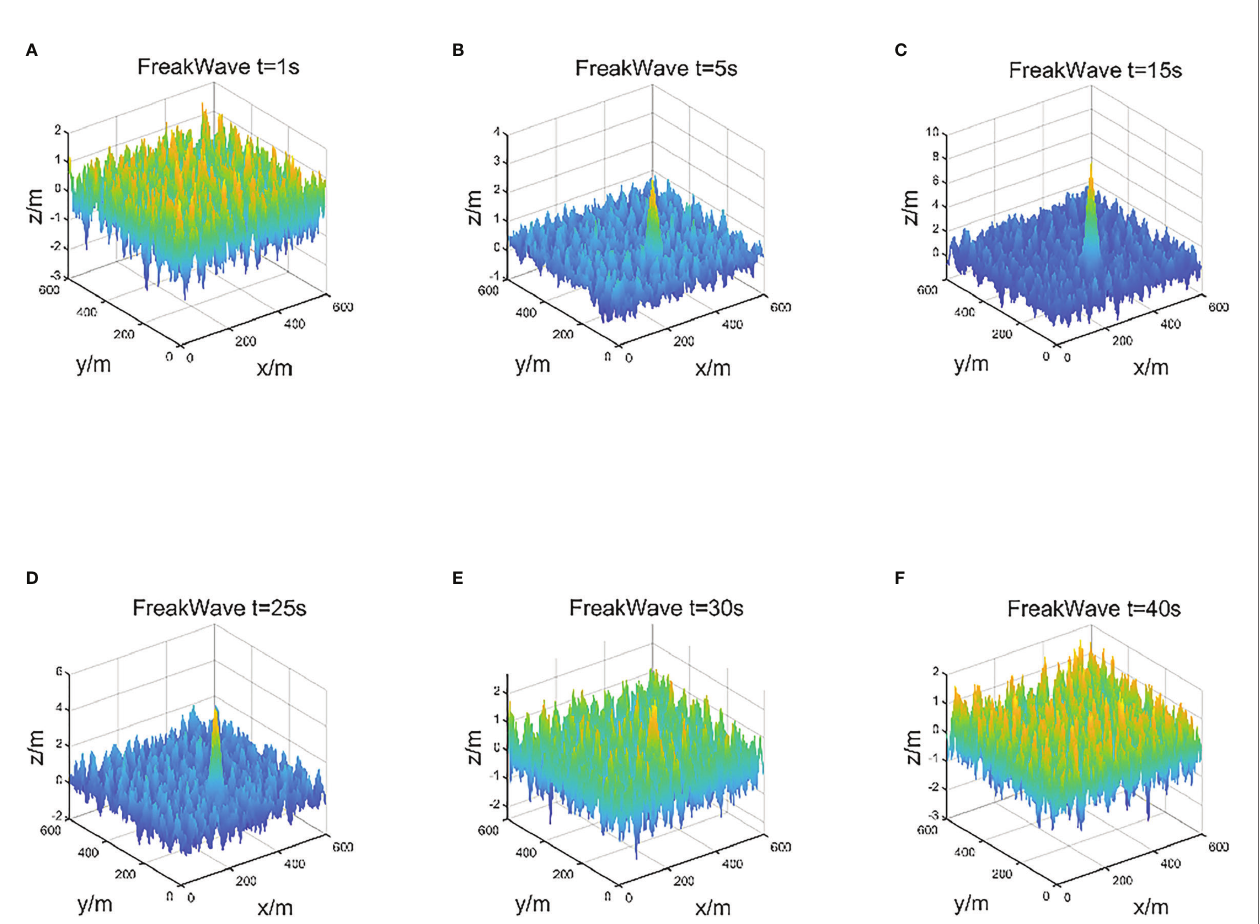
FIGURE 5 | U10 = 17m/s, The evolution of a freak wave on the 600×600 sea area. We recorded six states of the freak wave (A – F) in chronological order.